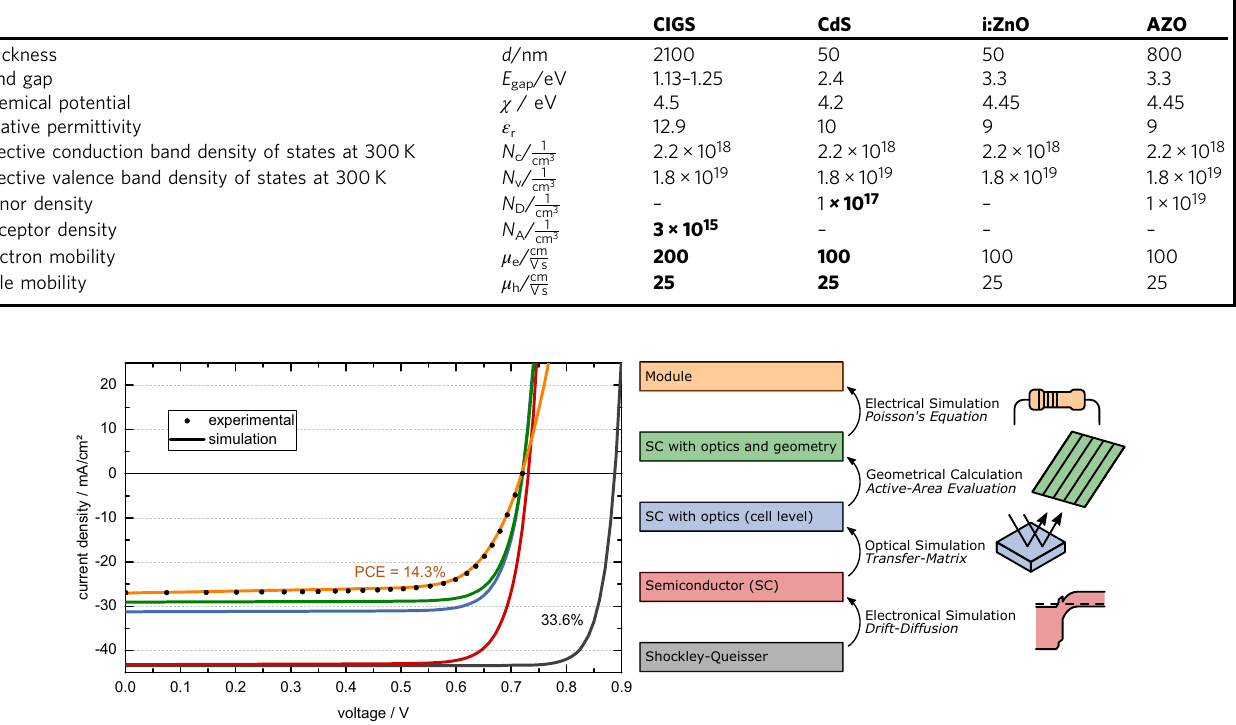
Fig. 1 All relevant I – V characteristics from Shockley – Queisser model to the actual module curve. The gray curve is the I – V characteristic of the Shockley- Queisser model for the band gap of the used module (1.13 eV). After performing a stand-alone drift – diffusion simulation with the parameters from Table 1, we end up at the red curve. The blue curve arises after further subtracting all optical losses and represents the in fi nitesimal small cell level. For the green curve, we included all geometrical losses of the module, and the orange curve emerges after electrical stimulation and represents the fi nal result for the module I – V characteristic of the stacked simulation. It has a power conversion ef fi ciency (PCE) of 14.3%. The black dotted curve shows actual measurements of the module.